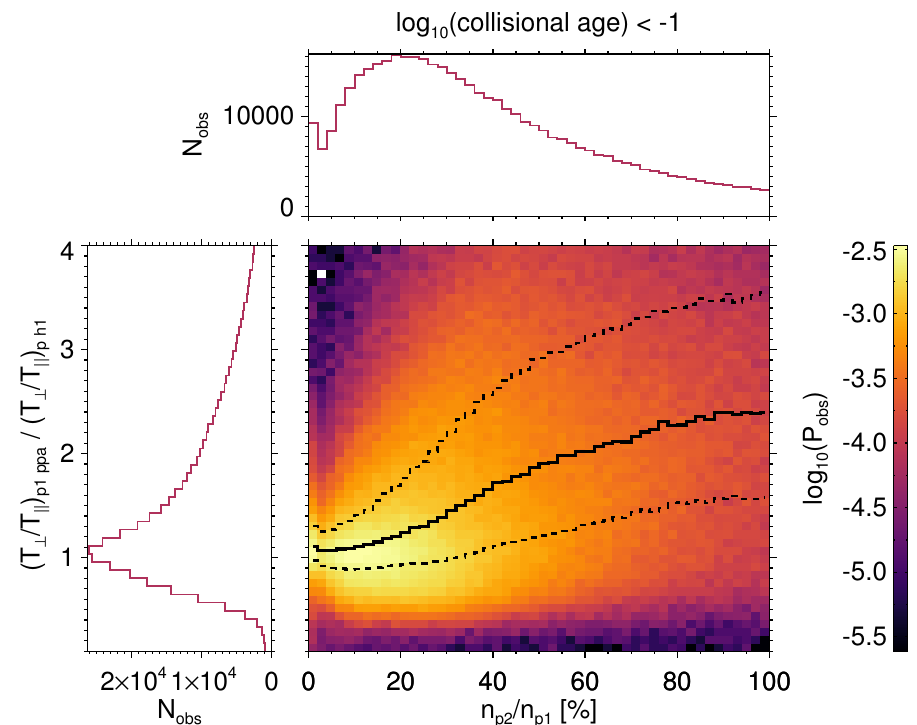
Figure 3. A comparison of results of two ways of Wind data processing. The 2D probability distribution of the ratio of T ⊥ / T (cid:107) determined by the PPA procedure and T ⊥ / T (cid:107) determined by the PA (procedure 1) as a function of the ratio of proton beam and proton core densities, n p 2 / n p 1 determined by the PPA is shown by a color scale. The probability of observations of mentioned ratios are shown by 1D histograms. See text for a detailed